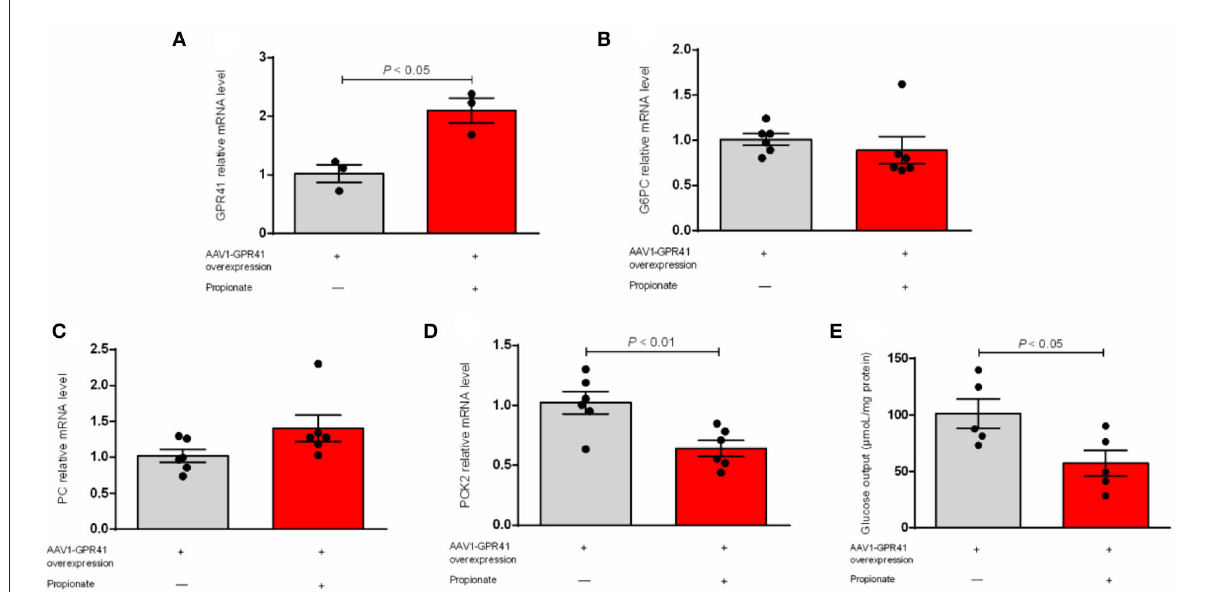
FIGURE3 Effect of GPR41 overexpression on the mRNA relative level of genes involved in gluconeogenic and glucose output in propionate-induced bovine hepatocytes. qRT-PCR analysis of GPR41 (A) , G6PC (B) , PC (C) , and PCK2 (D) expression levels ( n = 6). (E) GPR41 overexpression on the content of glucose output in propionate induced bovine hepatocytes ( n = 6). The relative expression of target genes was normalized to that of GAPDH. P < 0.05 were considered significant, and < 0.01 were highly